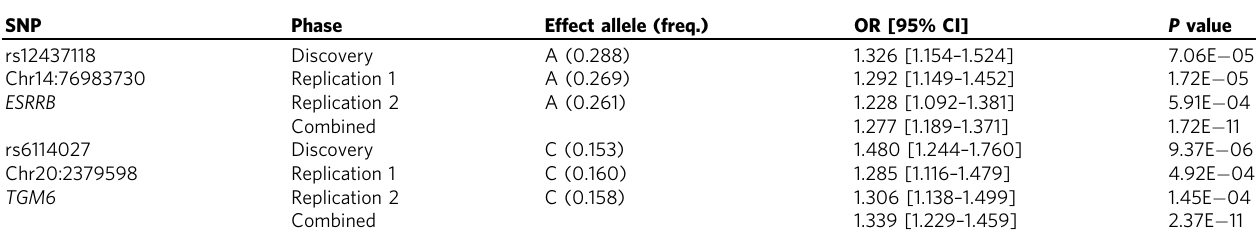
Table 1 Genome-wide signi fi cant association of two independent SNPs with TB SNP Phase Effect allele (freq.)